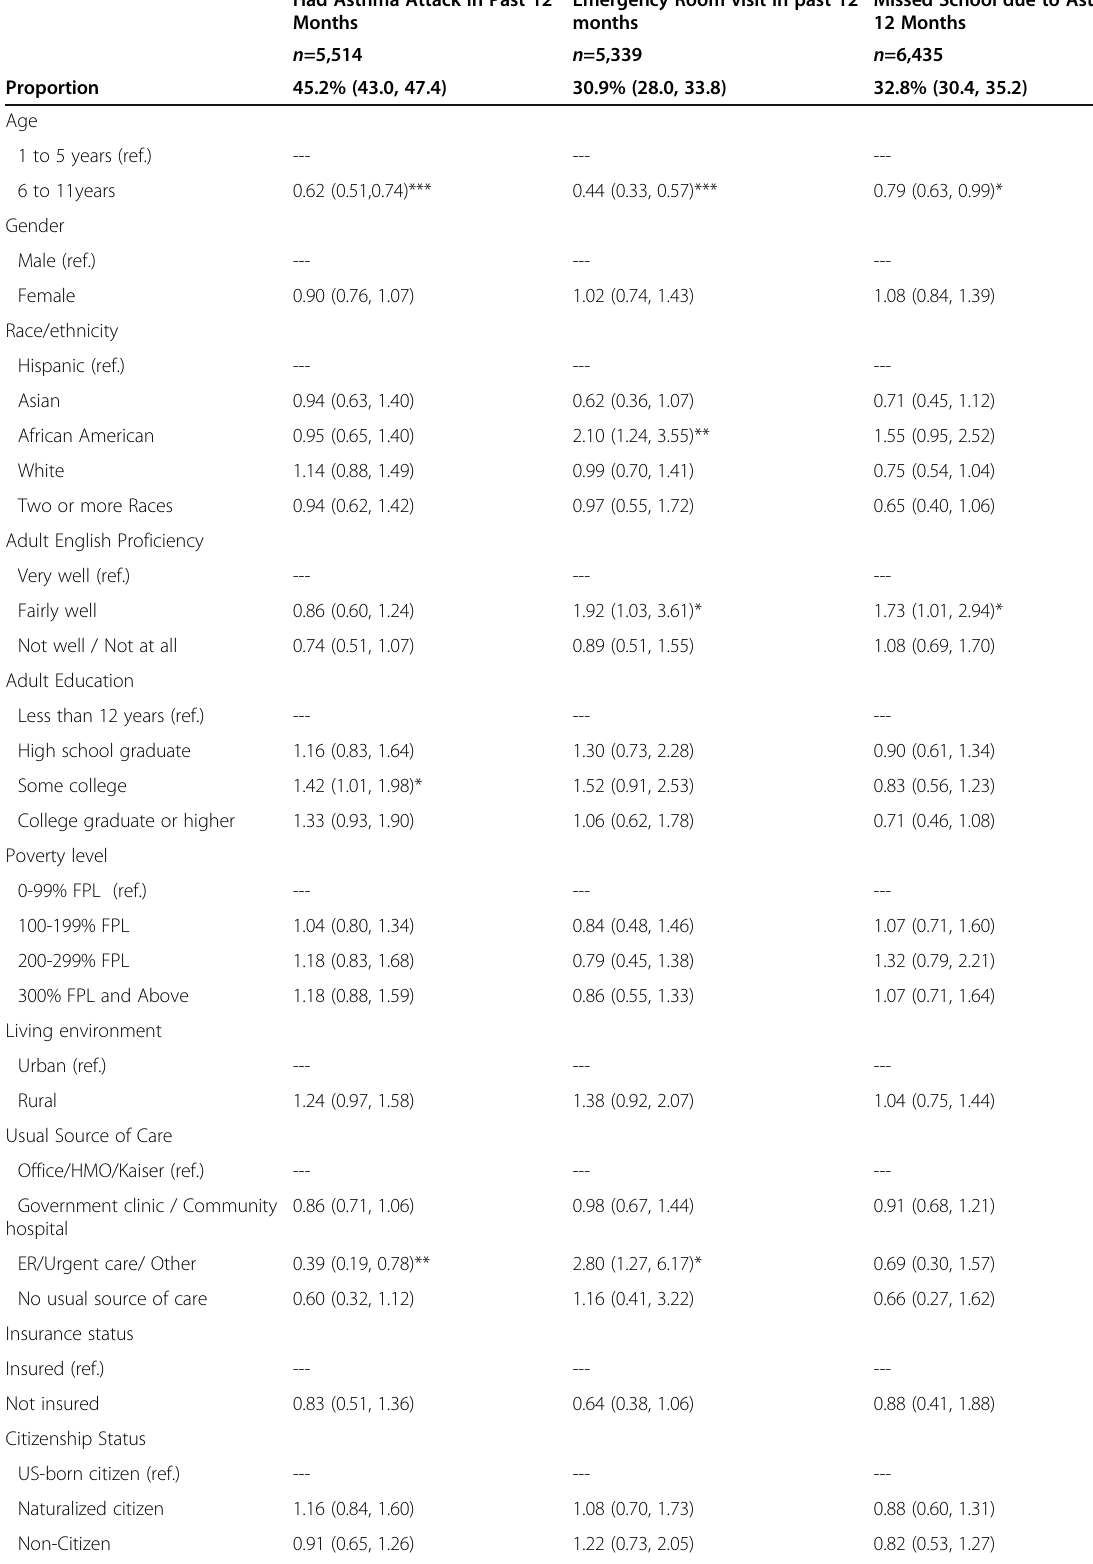
Table 4 Logistic Regression for Asthma